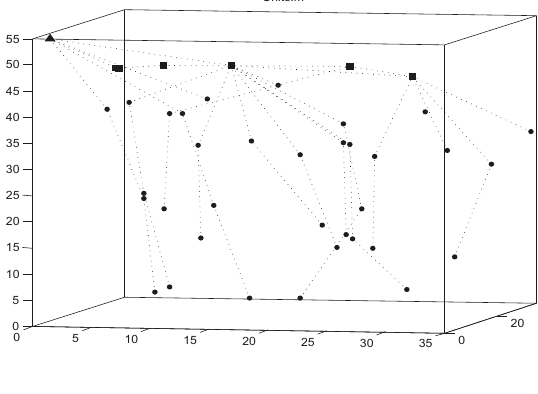
Figure 9. Node distribution